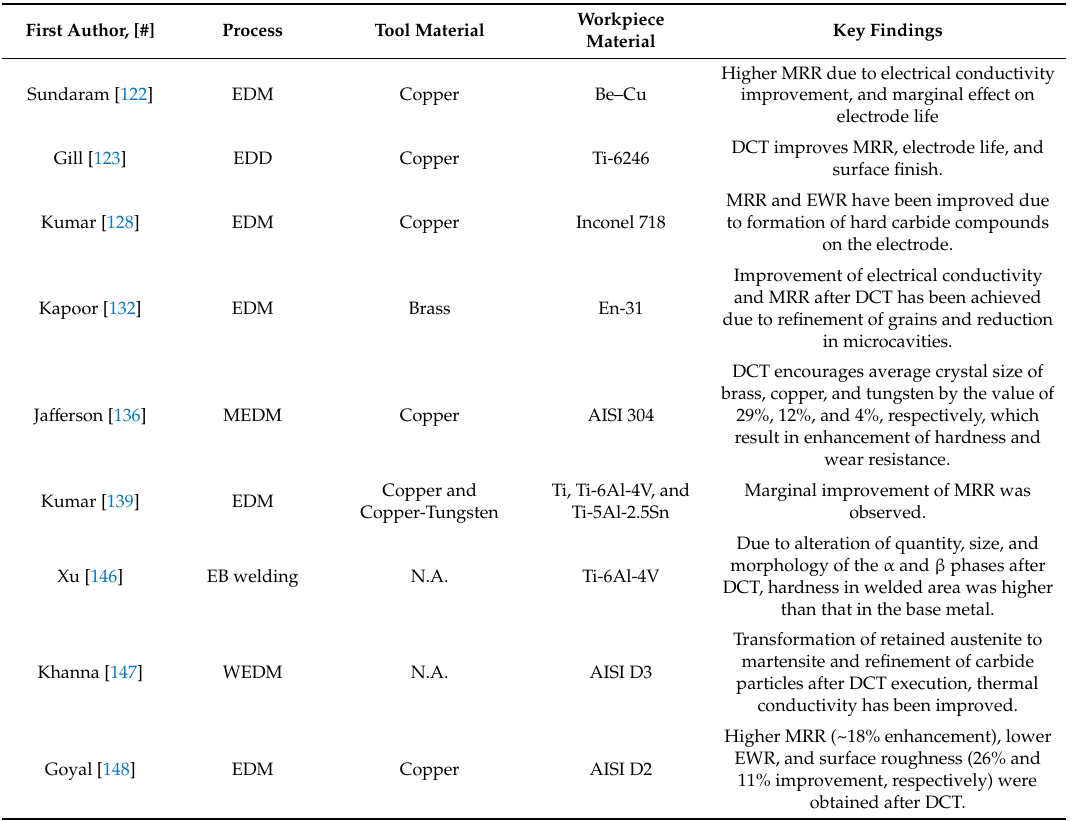
Table 4. Literature data related applying cryogenic treatment in nonconventional manufacturing